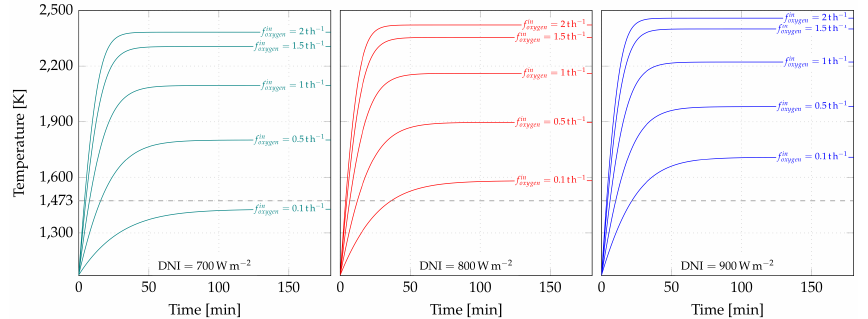
Figure 7. Evolution of the reactor’s temperature for various oxygen flow rates and DNI levels = 1.465th − 1 and the initial temperature is ( f in biomass